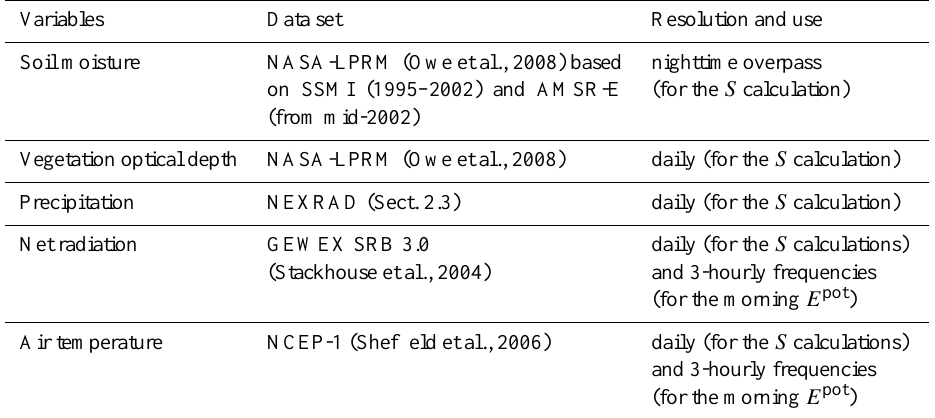
Table 2. Data sets used in GLEAM product. Daily aggregates are computed locally to match the before-noon evaporative fraction (EF) estimate (i.e., starting and ending at around 9a.m.; see Sect. 2.4). S and E pot are the evaporative stress and the potential evaporation, respectively. See Sect. 2.4 for